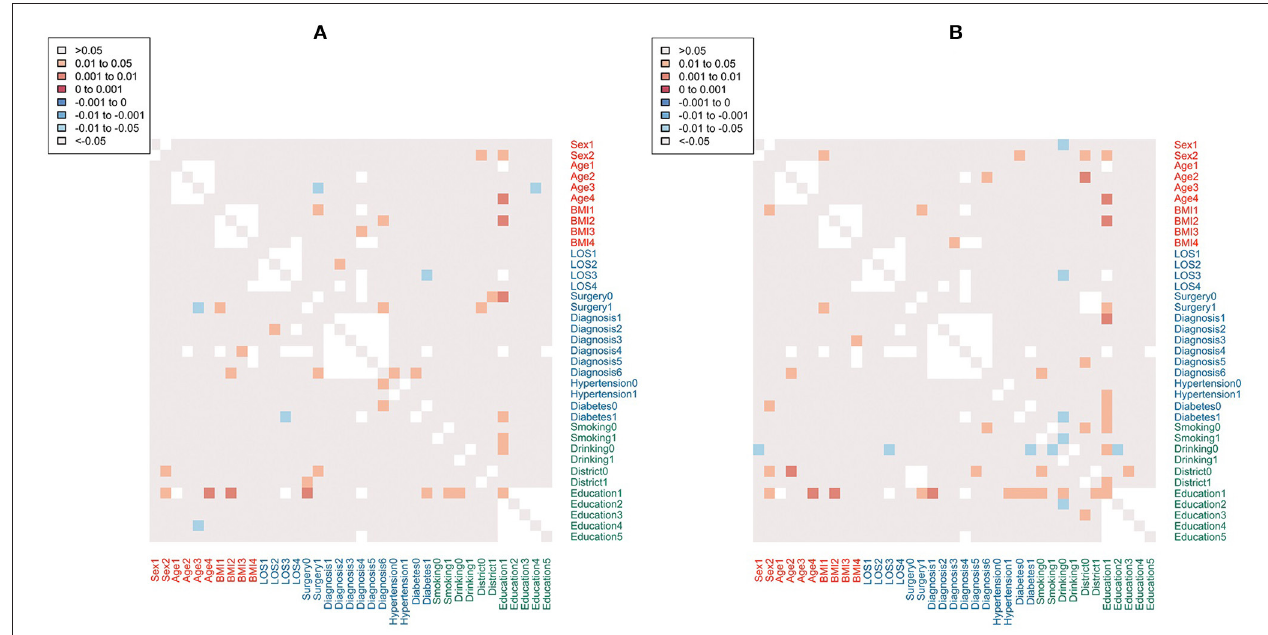
FIGURE 4 | Heatmaps of p values for hospital total costs (A) and LOS (B) between the high light side group and the low light side group by plural subgroups. Positive coefficients ( p > 0) indicate a direct relationship between variables (low light side > high light side); while negative coefficients ( p < 0) indicate an inverse correlation (low light side < high light side). No p -values if sample size is < 3. LOS, length of